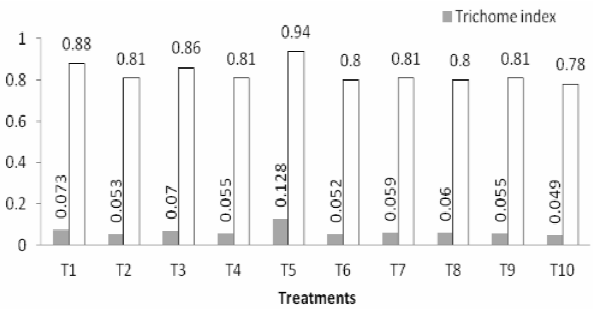
Fig. 2. Treatments T1 to T10 and corresponding Trichome index and artemisin content (%)